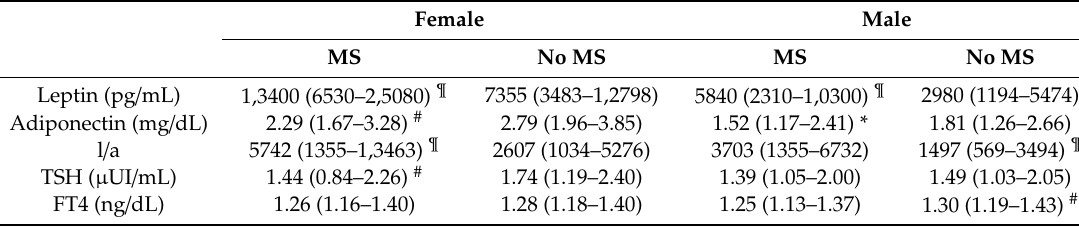
Table 2. Comparison between thyroid hormones and cytokines in subjects with and without metabolic syndrome, stratified by gender.